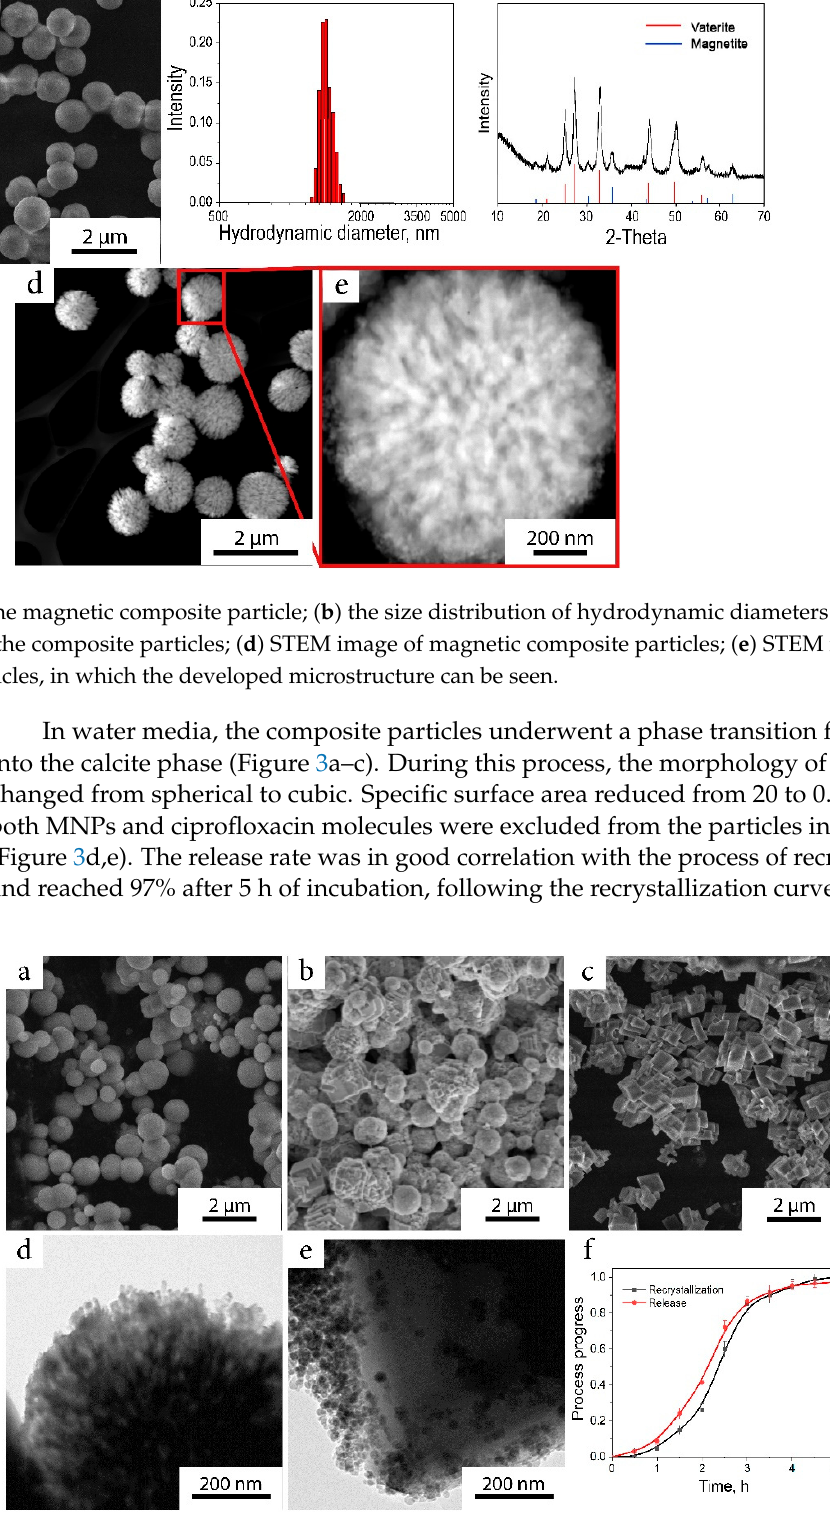
Figure 3. ( a – c ) Phase change of vaterite particles into calcite phase monitored by SEM; ( d ) TEM image of vaterite particle with even distribution of MNPs; ( e ) TEM image of calcite particle, MNPs are excluded to the surface; ( f ) release kinetics of ciprofloxacin compared to recrystallization dy- namics.